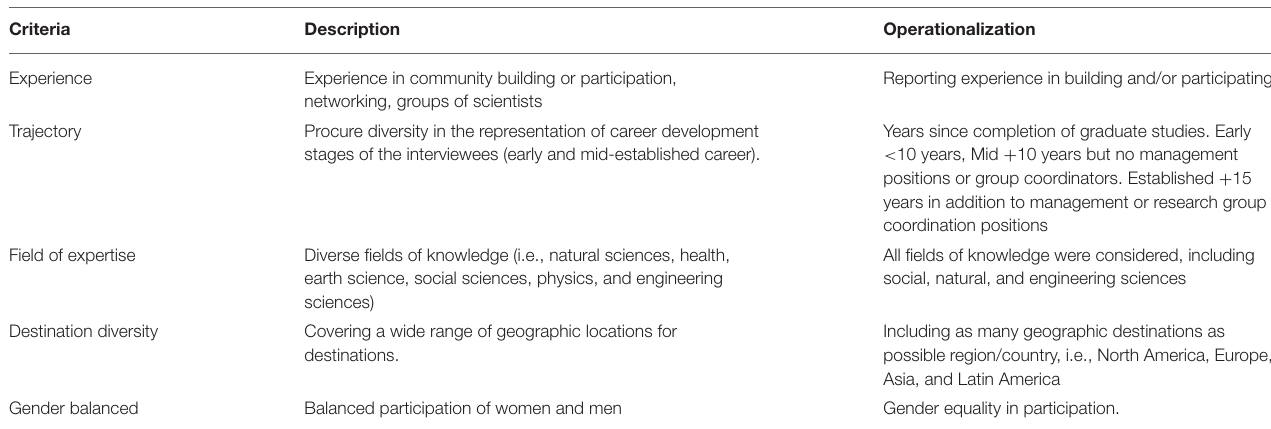
TABLE 2 | Criteria for participant selection: focus group discussions, Guatemala scientific community.